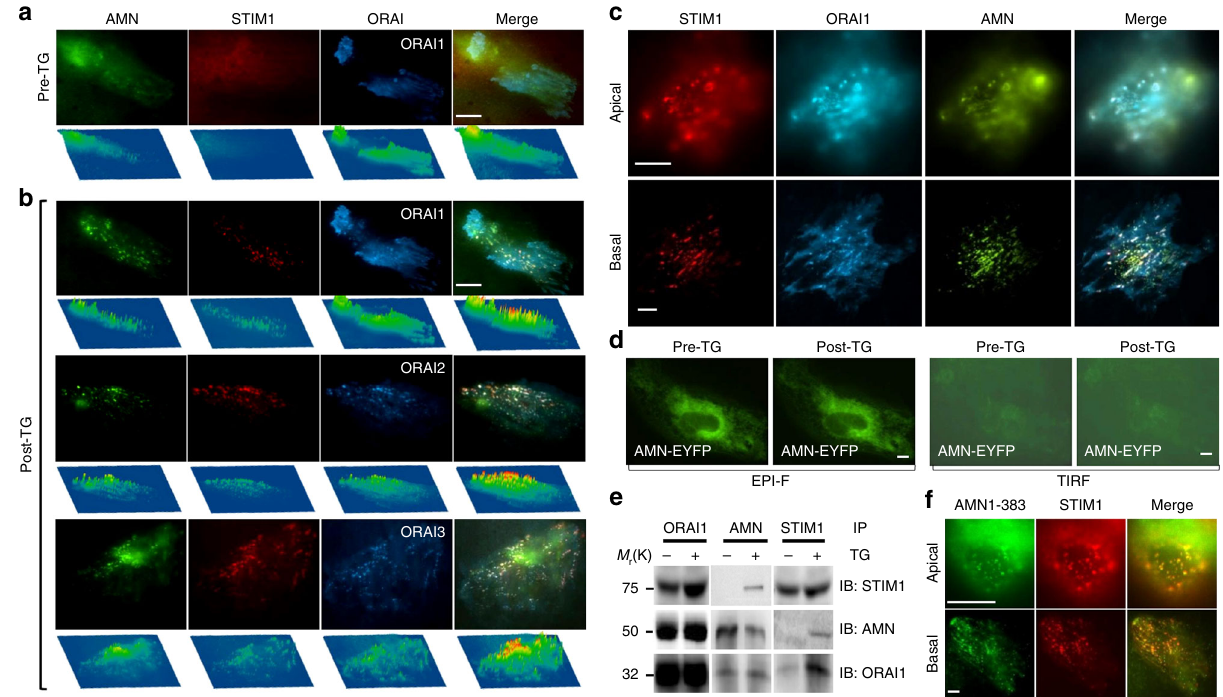
Fig. 5 Subcellular localization and interaction of amnionless (AMN), STIM1 and ORAIs in PTECs. PTECs were cotransfected with AMN-EYFP, STIM1-mCherry and CFP-ORAIs and fl uorescence was examined before and after treatment with thapsigargin (TG, 1 µ M) for 10min using TIRF microscopy with objective (× 100). a Before TG treatment (Pre-TG). b After store-depletion with TG (post-TG). The fl uorescence distribution pattern and intensity (below each image) are shown for cells transfected with CFP-ORAI1, CFP-ORAI2, and CFP-ORAI3, respectively, plus AMN-EYFP and STMI1-mCherry. c Pictures show the localization of STIM1-mCherry, CFP-ORAI1 and AMN-EYFP at the apical and basal membrane of human PTECs after treatment with 1 µ M TG for 10min. d No signi fi cant clusters were formed before or after treatment with SERCA blocker TG (1 µ M) in PTECs transfected with AMN-EYFP alone. Images were taken from Epi-Fluorescence (EPI-F) and TIRF microscopy. e Co-immunoprecipitation of STIM1, ORAI1 and AMN endogenously expressed in PTECs with/without TG treatment. f Colocalization of intracellular C terminus-truncated AMN (AMN1-183) with STIM1 in PTECs after Ca 2+ store depletion. Scale bars, 10 µ